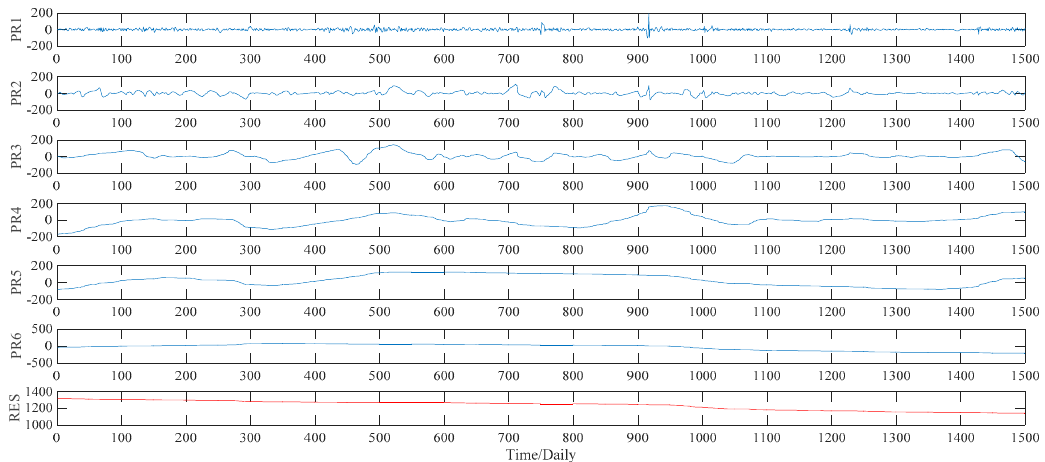
Figure 21. Decomposition results of the ITD method (soybean).